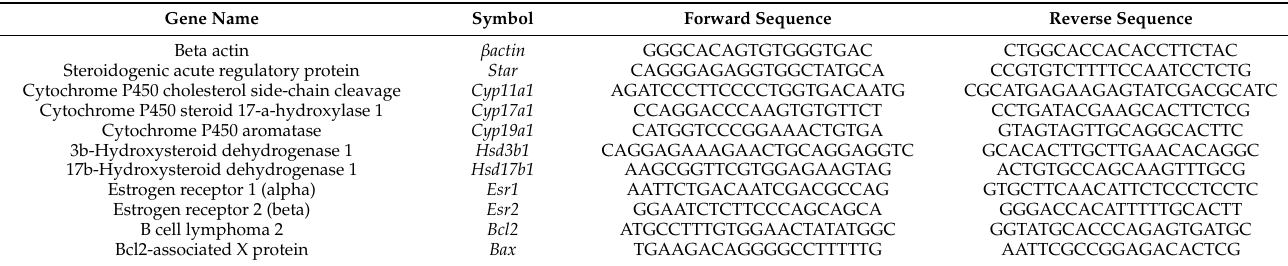
Table 1. Genes and primer sequences used in